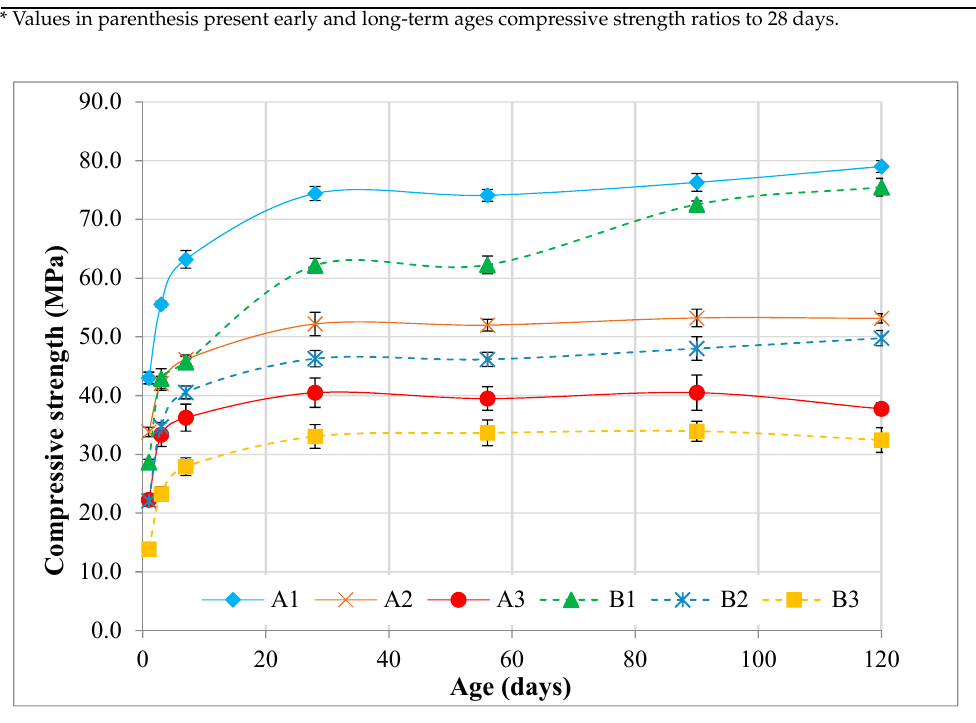
Figure 9. FESEM of the control mix containing FA. Due to the observed gap in the ITZ, points A and B were selected to be focused on.